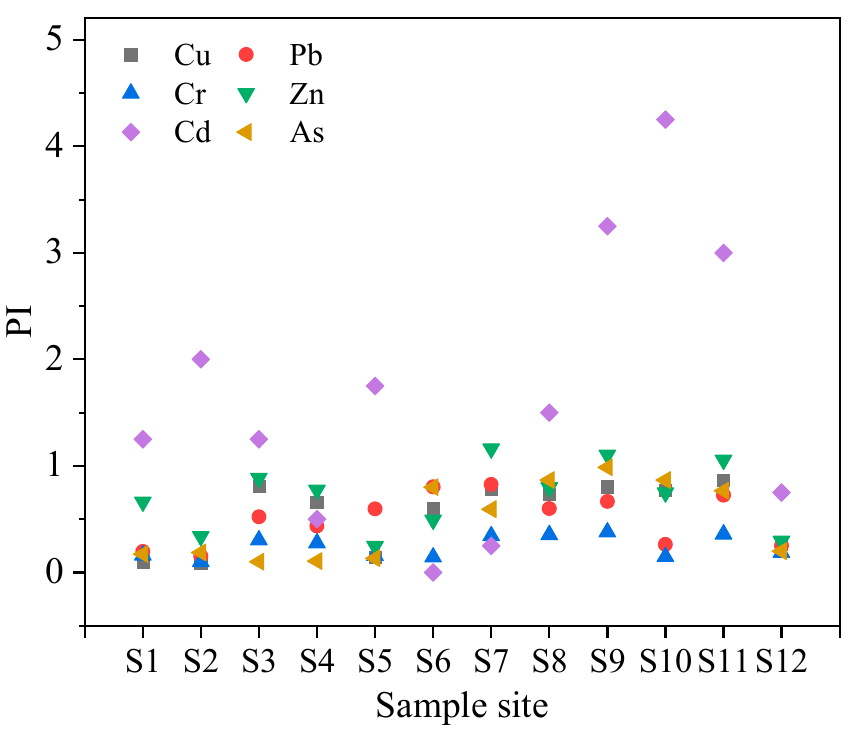
Figure 3. Single factor index (PI) distribution of heavy metals in surface sediments of Hulun Lake.